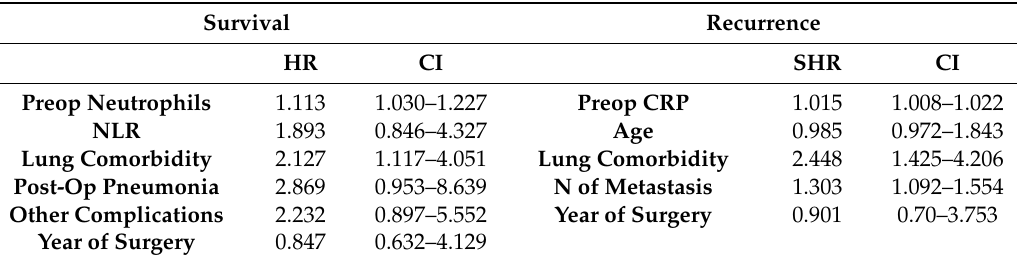
Table 4. Results of multivariate